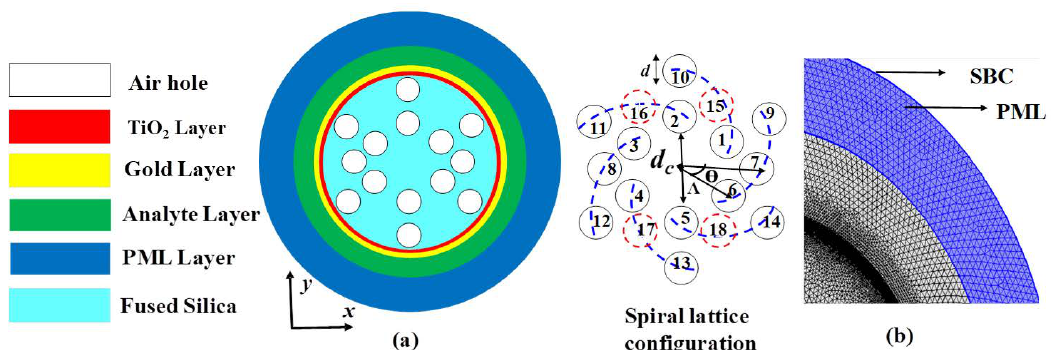
Figure 1. ( a ) Two-dimensional cross-section view of the proposed spiral photonic crystal fiber (PCF) sensor. ( b ) Computational meshing domain with optimized design parameters. PML, perfectly matched layer; SBC, scattering boundary